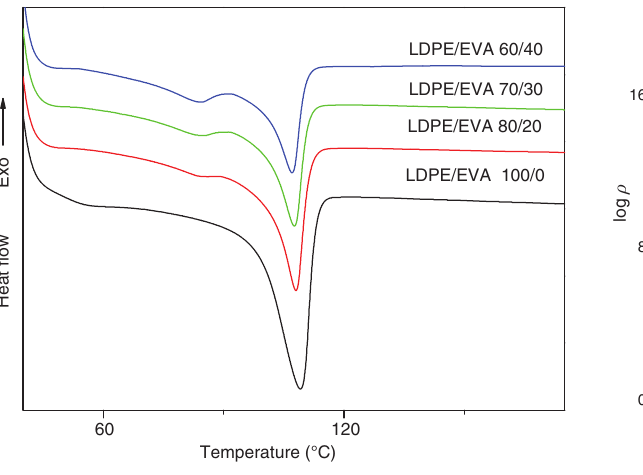
Figure 3: The DSC curves of LDPE/EVA/CB composites. Figure 4: Resistivity of composites with different ratios of LDPE to EVA vs. CF